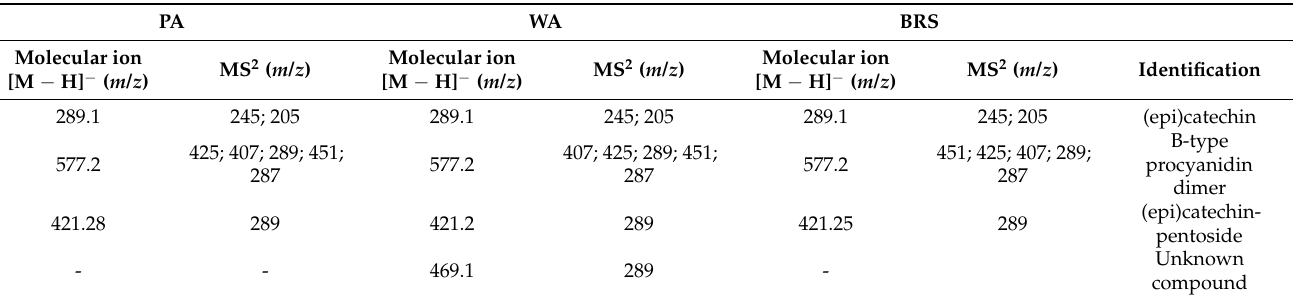
Table 2. PA, WA, and BRS EtOAc fractions by ESI–MS/MS direct